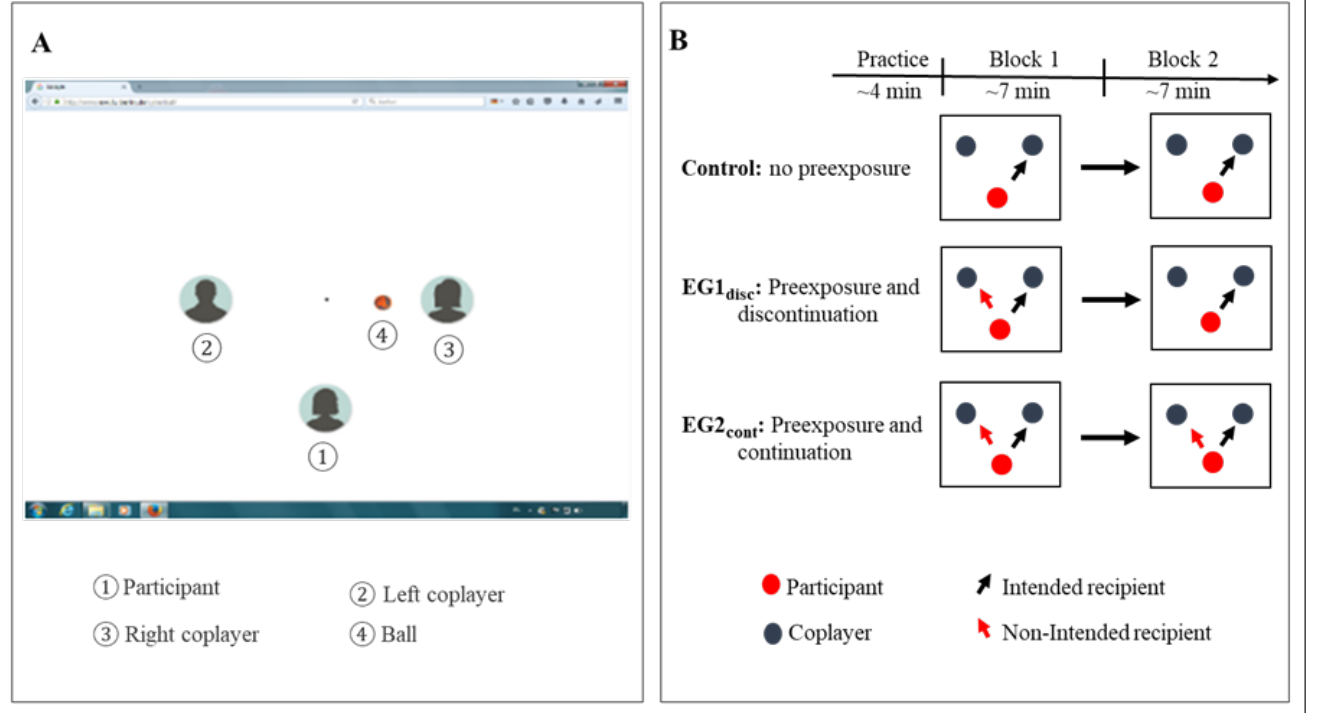
Figure 1. ( A ) Setup of the visual display. The participant and the two putatively connected co-players are represented as avatars. The participant’s avatar was always at a central position. ( B ) Experimental design. Pictograms refer to the experimental condition in the first and second block of the Cyberball game. The control group remained control in the first block and was excluded in the second block. EG1 disc : In addition to the transition to exclusion, participants experienced a loss of control exclusively in block 1 (discontinued preexposure). EG2 cont : In addition to the transition to exclusion, participants experienced a loss of control in block 1 and lock 2 (continued preexposure).